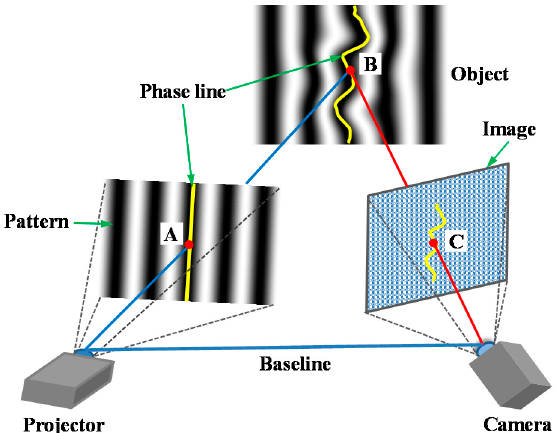
Figure 1. The schematic diagram of a typical fringe projection profilometry (FPP) setup, which consists of a camera and a projector. A , B and C are the points of the same phase point on the pattern, the object surface, and the captured image, separately.